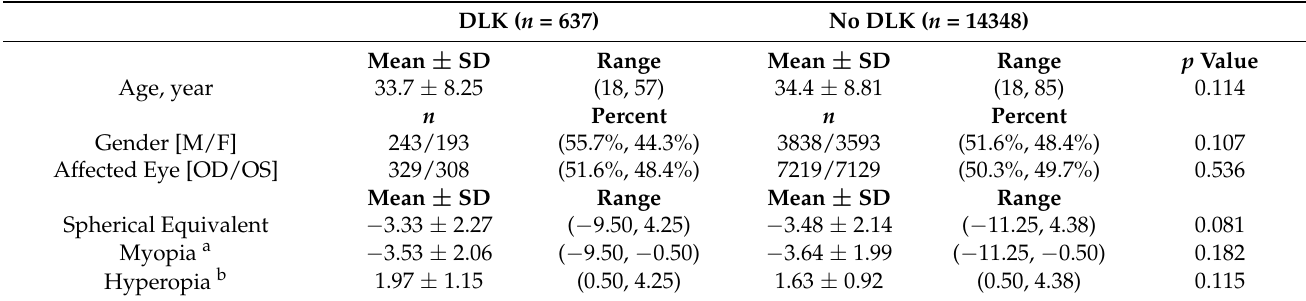
Table 1. Demographics and risk factors of patients with diffuse lamellar keratitis following LASIK.